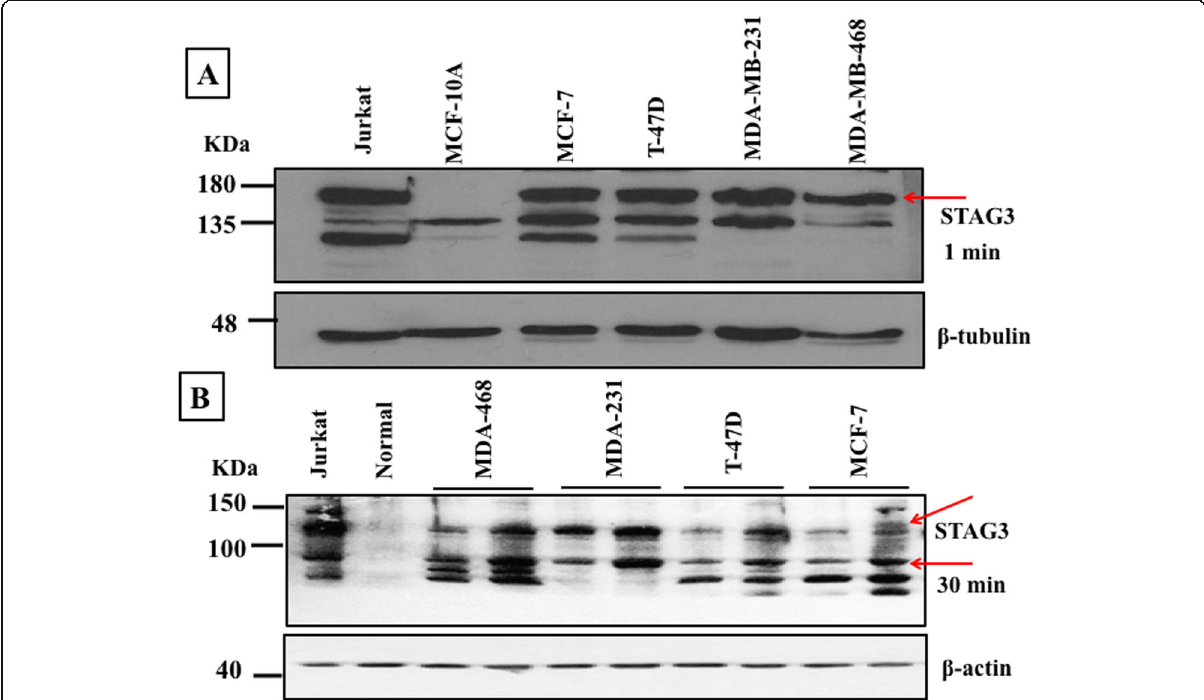
Fig. 1 STAG3 protein levels in breast cancer cell lines relative to the normal. Protein lysates were extracted from the cell pellets of normal breast and cancer cell lines to study STAG3 protein levels by Western blot. From each cell line, four samples from different flasks were used. a Western blot analysis was performed using Sigma-Aldrich anti-STAG3 antibody to determine the putative protein level of STAG3 in the breast cancer cell lines compared to the positive control, Jurkat cells, and the negative control, MCF-10A. β -Tubulin was used as a loading control. b Western blot analysis was done on two separated protein lysates of each breast cancer cell line and compared to protein lysate extracts of the normal breast and Jurkat cell line. Abcam anti-STAG3 antibody was used to show the putative STAG3 protein level. β -Actin was the loading control. Data shown in a and b represent four experiments for